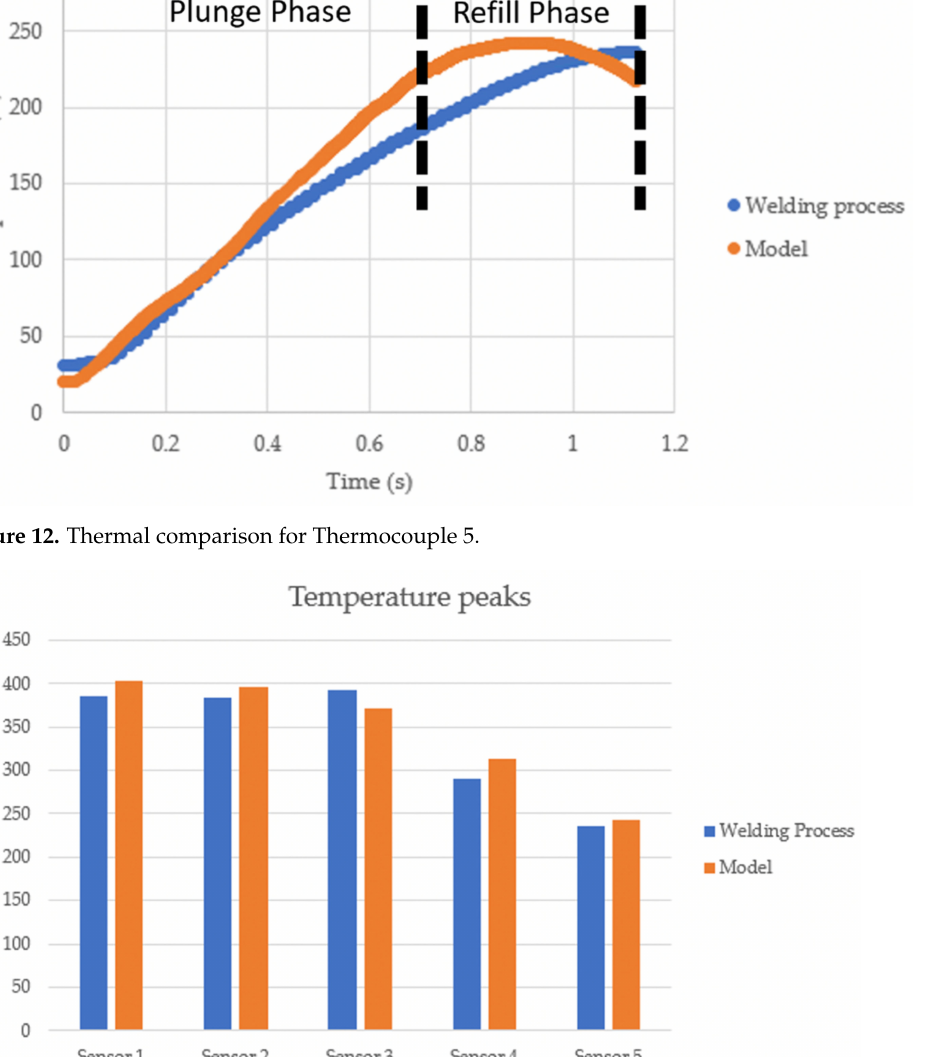
dominates for the RFSSW process. Figure 14b–d show the temperature evolution that occurs as the material is heated by the rapid rotation of the tools and consolidated by the relative motion of the pin and shoulder. The heat generation in the model is consistent with the experimental data, which is important if the material flow is to be simulated